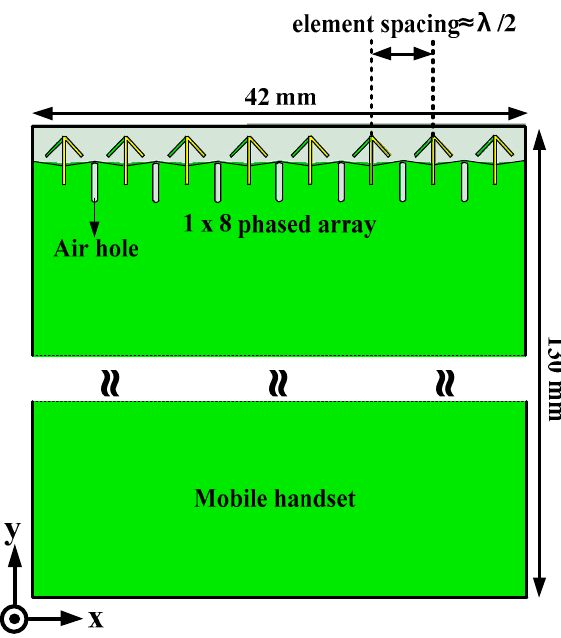
Figure 8. Top view of the proposed 1 × 8 phased array antenna on a mobile handset ground.